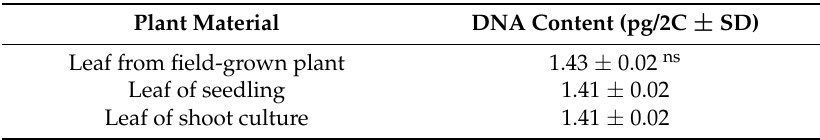
Table 3. Nuclear DNA content in leaves of Chaenomeles japonica field-grown plant, seedling, and in vitro-propagated plantlets.